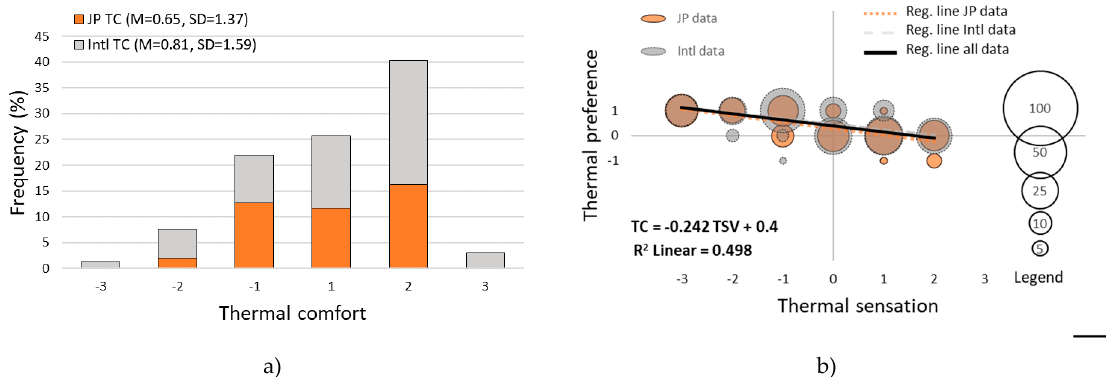
Figure 10. The frequency distributions and correlation between thermal responses; ( a ) Distribution of TC; ( b ) correlation TP: TSV. Table 6. Correlation between thermal responses.